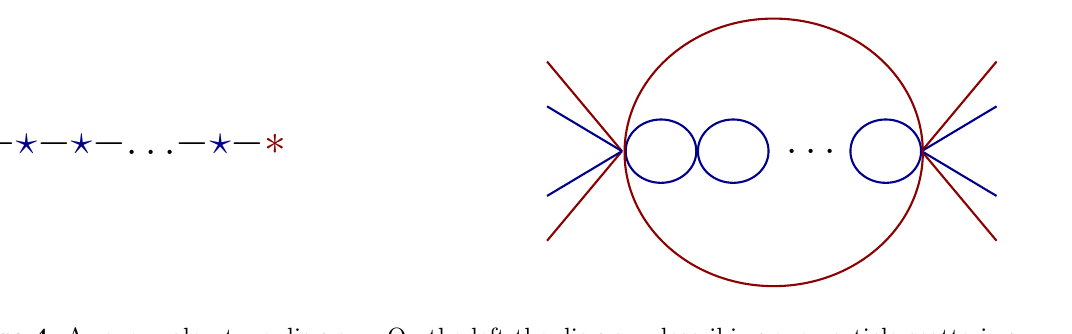
Figure 4 . A renormalon-type diagram. On the left the diagram describing one-particle scattering o(cid:11) a potential. On the right a corresponding diagram in the language of 4-particle